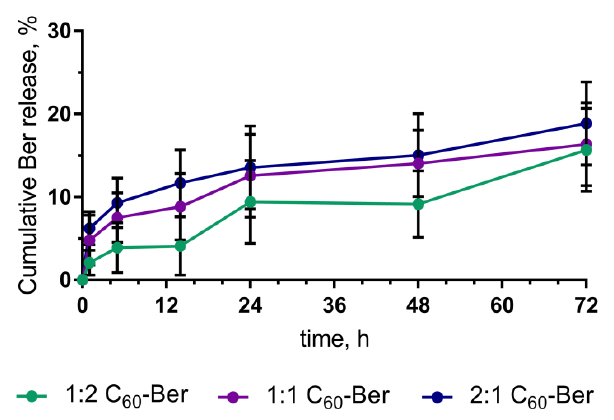
Figure 6. The energy-minimized structure of 1:1 C 60 -Ber